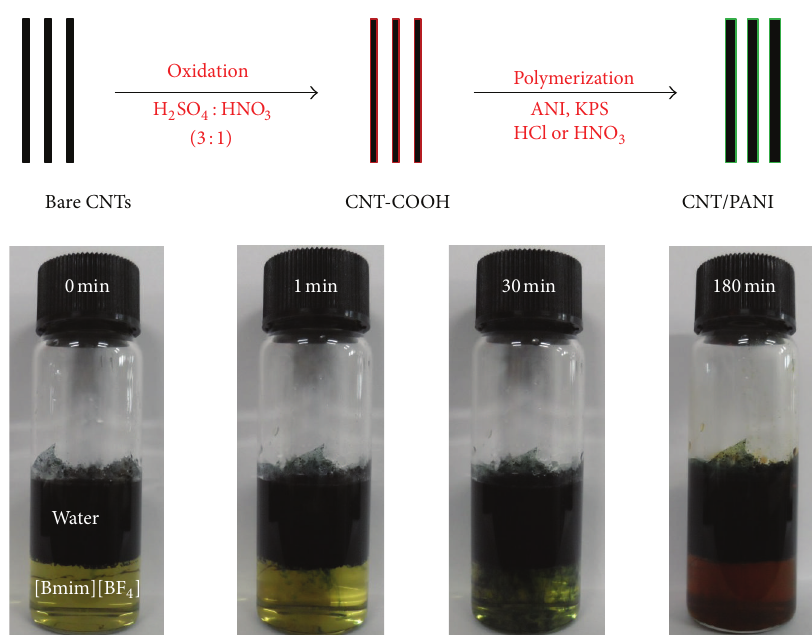
Scheme 1: Schematic diagram of the synthesis of the CNT/PANI composite and the progress of the interfacial polymerization of aniline in a water/IL system in the presence of CNT.